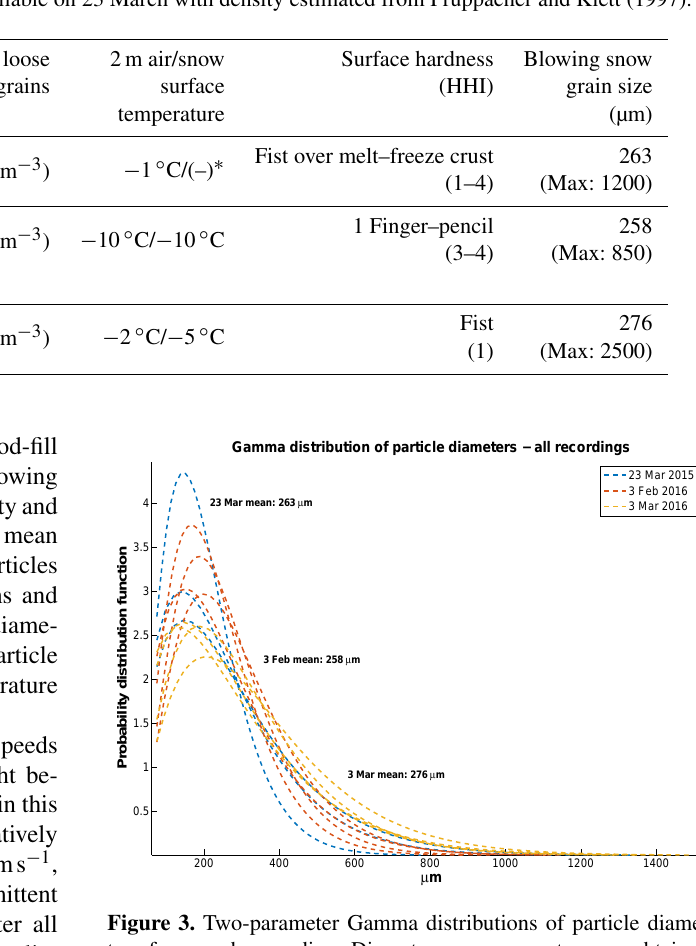
Table 1. Descriptions of the snowpack for each night of recording including a description of the condition of the snow surface and concurrent precipitation, bulk density of the top 5cm of grains, mean air temperature at the upper anemometer, snow surface temperature, hand surface hardness, and hand hardness index (HHI) values following Fierz et al. (2009), as well as snow grain size as determined from the blowing snow video. ∗ Density and snow surface temperature not available on 23 March with density estimated from Pruppacher and Klett (1997).